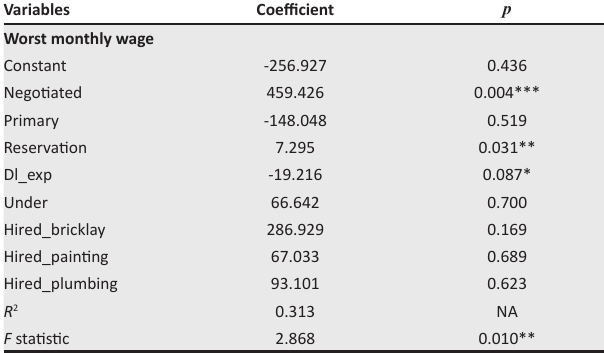
TABLE 1-A2: Income model with the worst monthly wage.